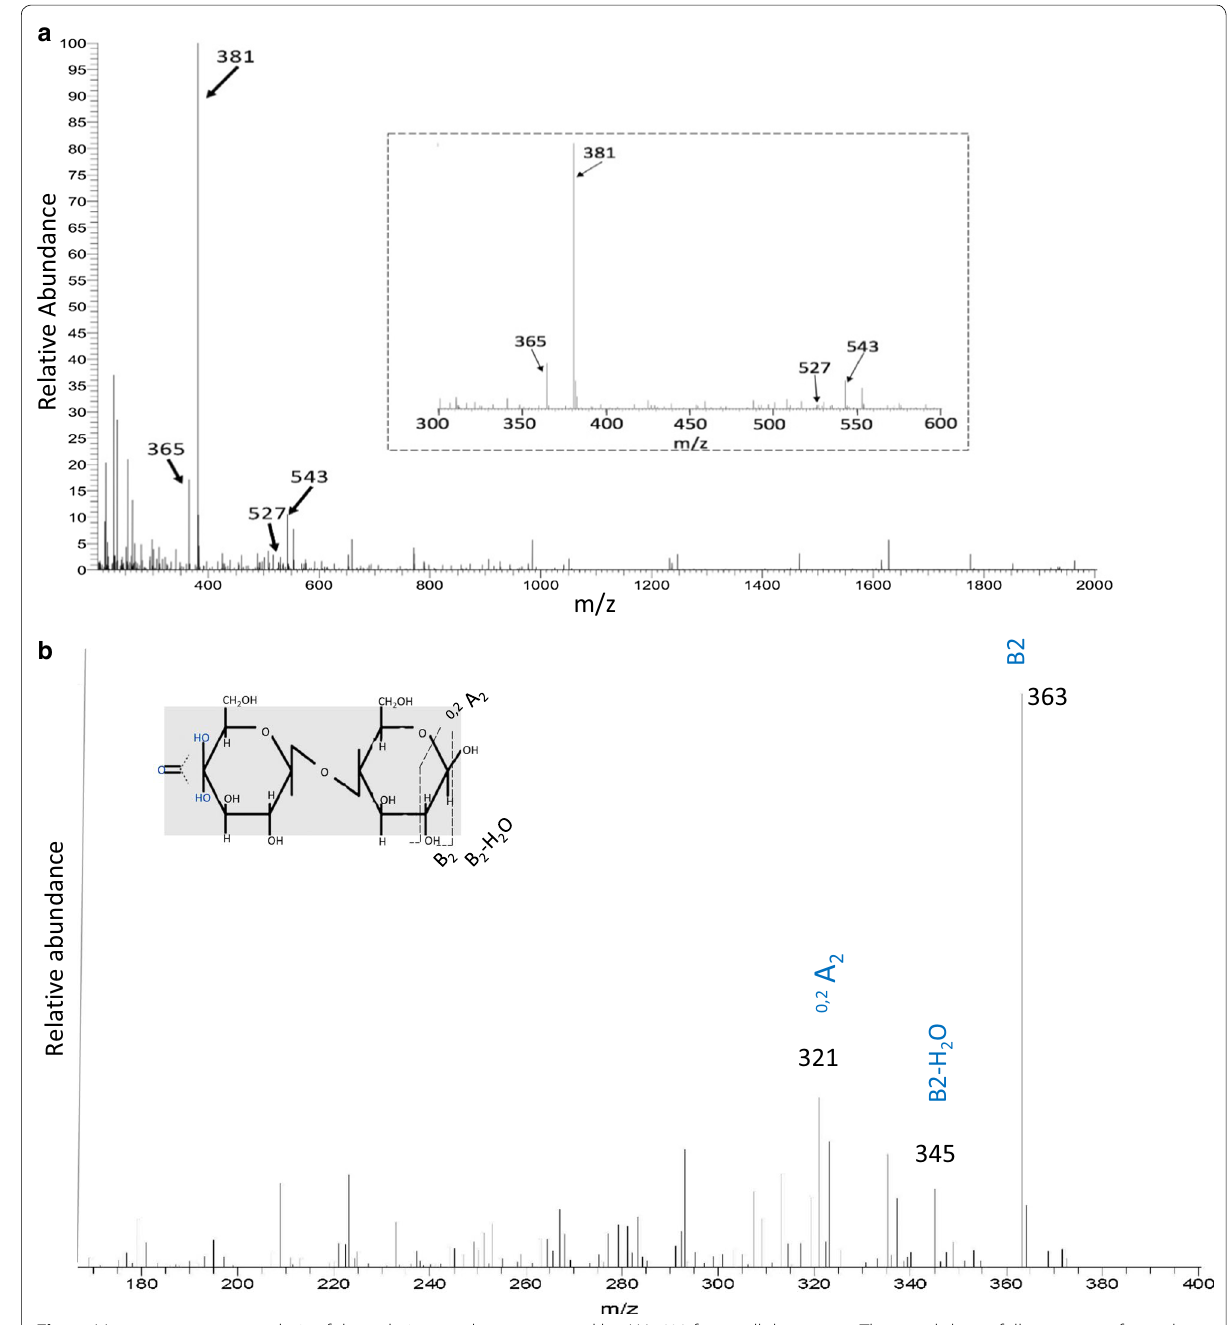
Fig. 4 Mass spectrometry analysis of degradation products generated by AN1602 from cellohexaose. a The panel shows full spectrum of sample with peaks corresponding to native and oxidized cello-oligosaccharides after 24 h of cellohexaose degradation by AN1602.The inset shows the close-up of the spectra in the m/z 300–600. b MS/MS spectra of oxidized product with m/z 381 that was further fragmented. Masses are labeled based on expected fragmentation from the C4 oxidized product Glc4gemGlc. The inset shows the likely position of fragmentation products from